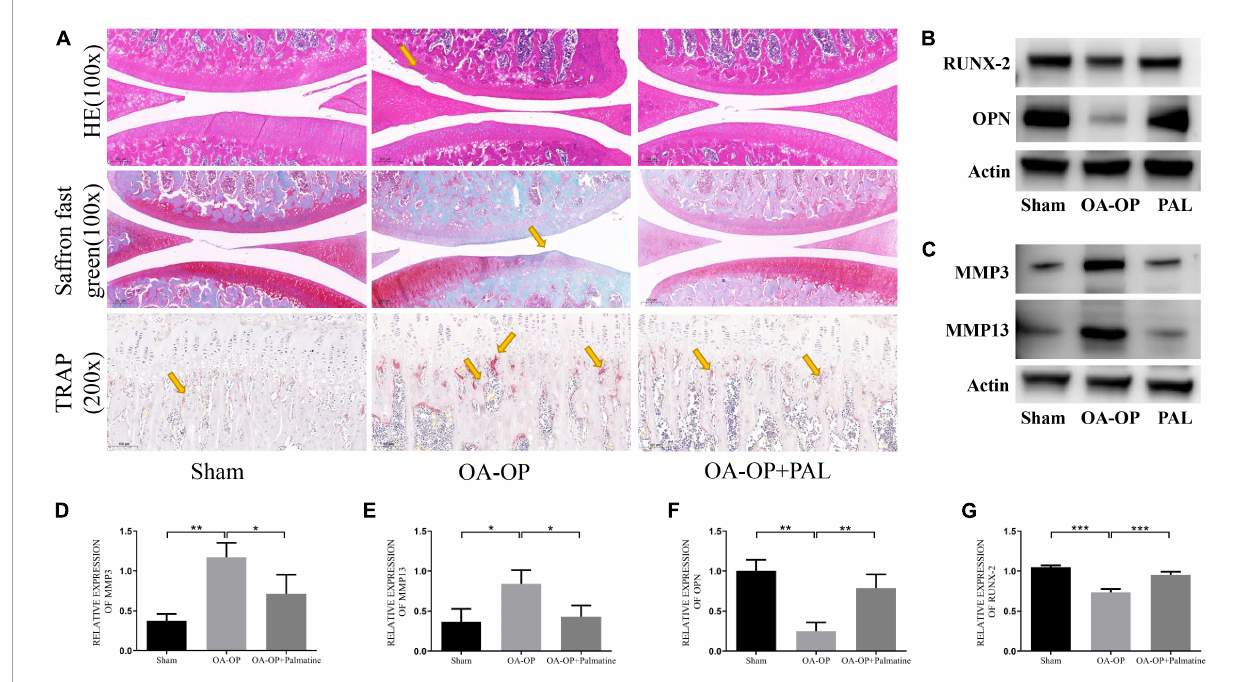
FIGURE4 Effect of PAL on bone pathological section of Op Oa Rats. (A) Representative pictures of rat knee tissue sections stained with H & E, Saffron O/Fast Green and TRAP. (B) Representative images of protein bands in rat tissues. (C) Representative images of protein bands in rat cartilage. (D) The relative expression levels of MMP3 in cartilage. (E) The relative expression levels of MMP13 in cartilage. (F) The relative expression levels of OPN in femur. (G) The relative expression levels of RUNX-2 in femur. *Statistically significant difference ( P < 0.05). **Statistically significant difference ( P < 0.01). ***Statistically significant difference ( P <